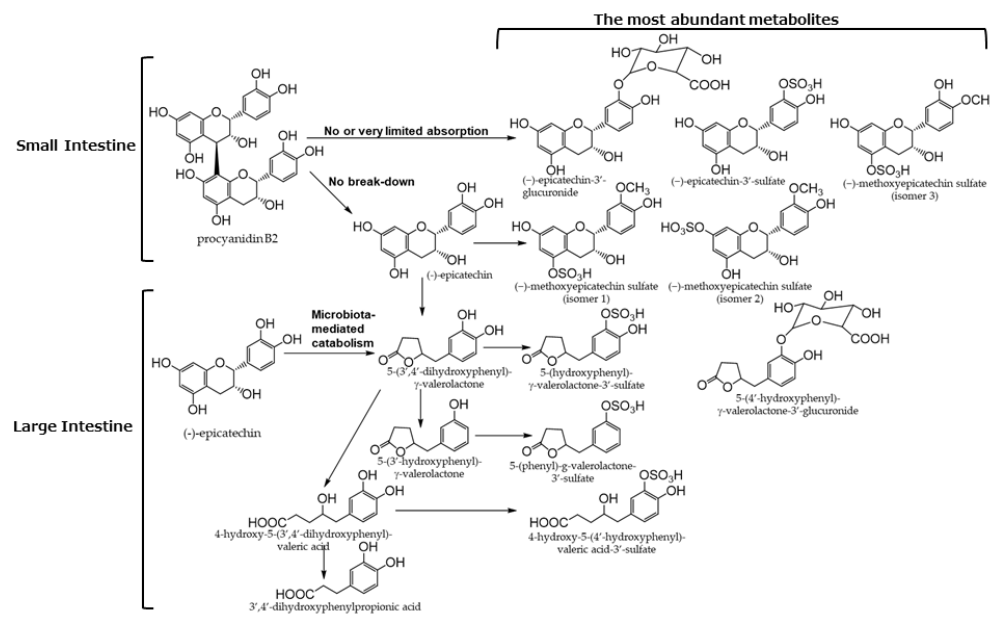
Figure 5. Biotransformation pathways of main flavonols in humans. Quoted from